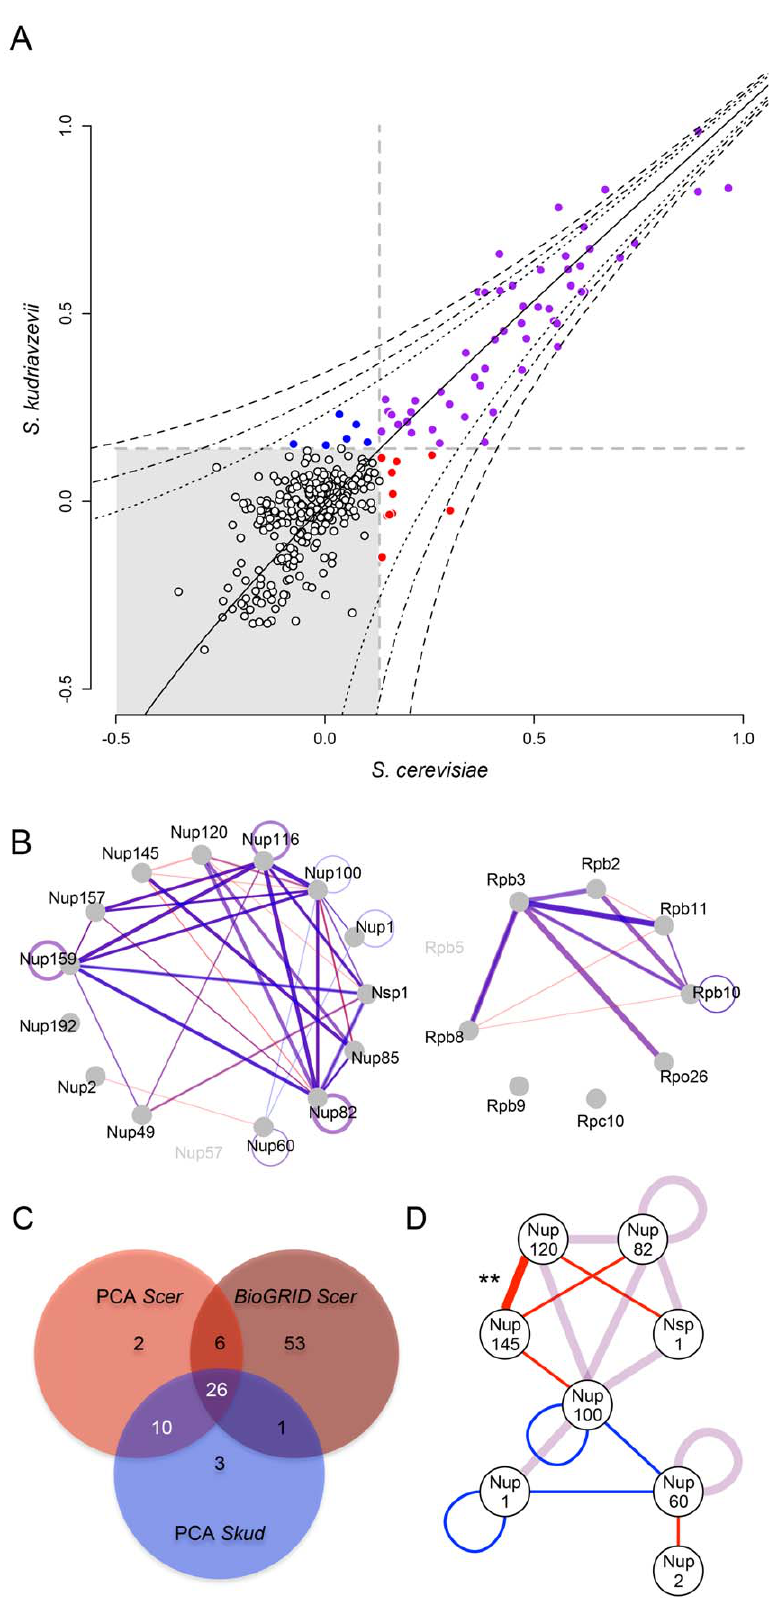
Figure 3. The NPC and RNApII networks are largely conserved between Scer and Skud . ( A ) Comparison of SI values (strains growth signal index; log 10 ) between species. Grey dotted lines indicate SI threshold values ( t ). SI values were considered to correspond to interactions when greater than t in both species (purple) or specific to one species when greater than t only in Scer (red), or only in Skud (blue). Black dotted lines indicate 5%,